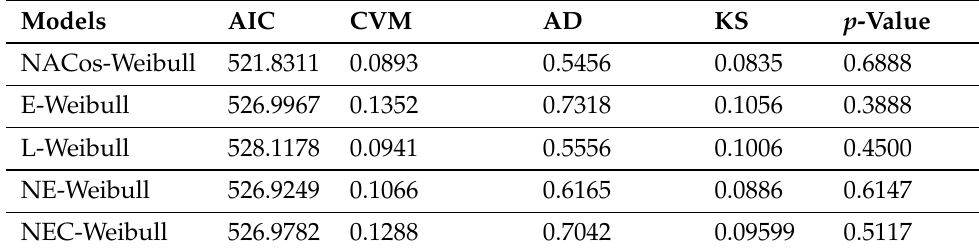
Table 6. For the flood peaks data set, the values of selection criteria of the fitted